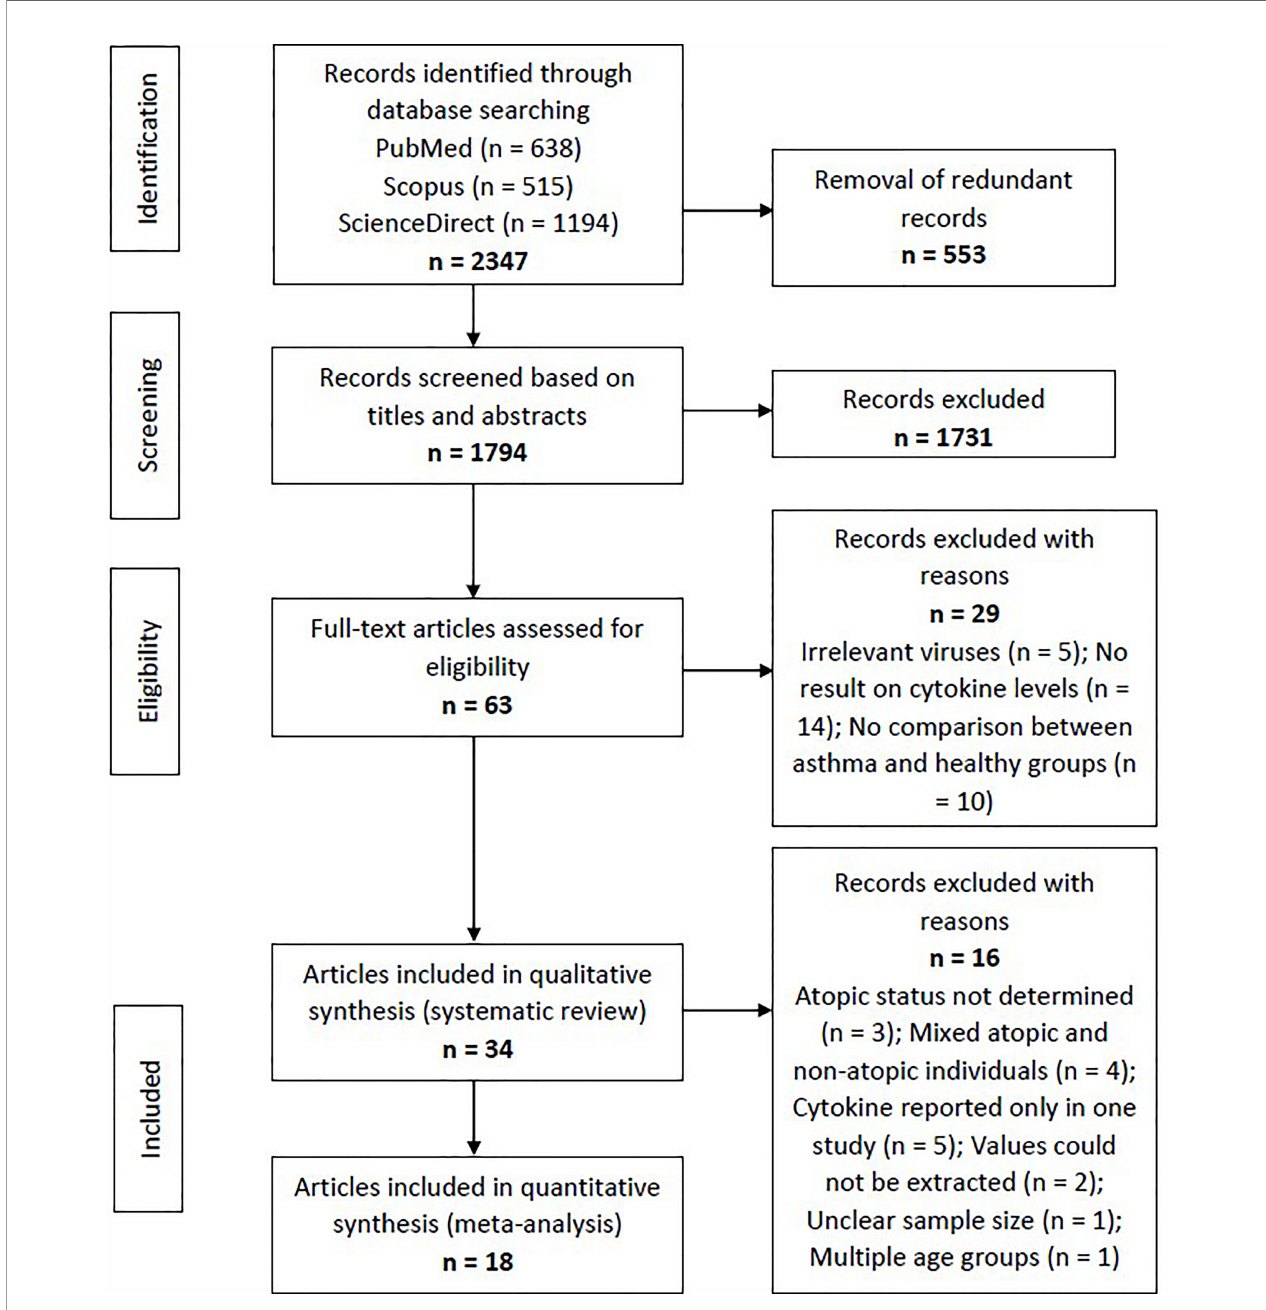
FIGURE 1 | Flowchart showing the selection process of articles according to the PRISMA Statement. From the initial 1794 non-redundant articles, 34 articles reporting RV-induced cytokine responses in asthmatic and healthy individuals were included in the systematic review, with 18 of these further subjected to